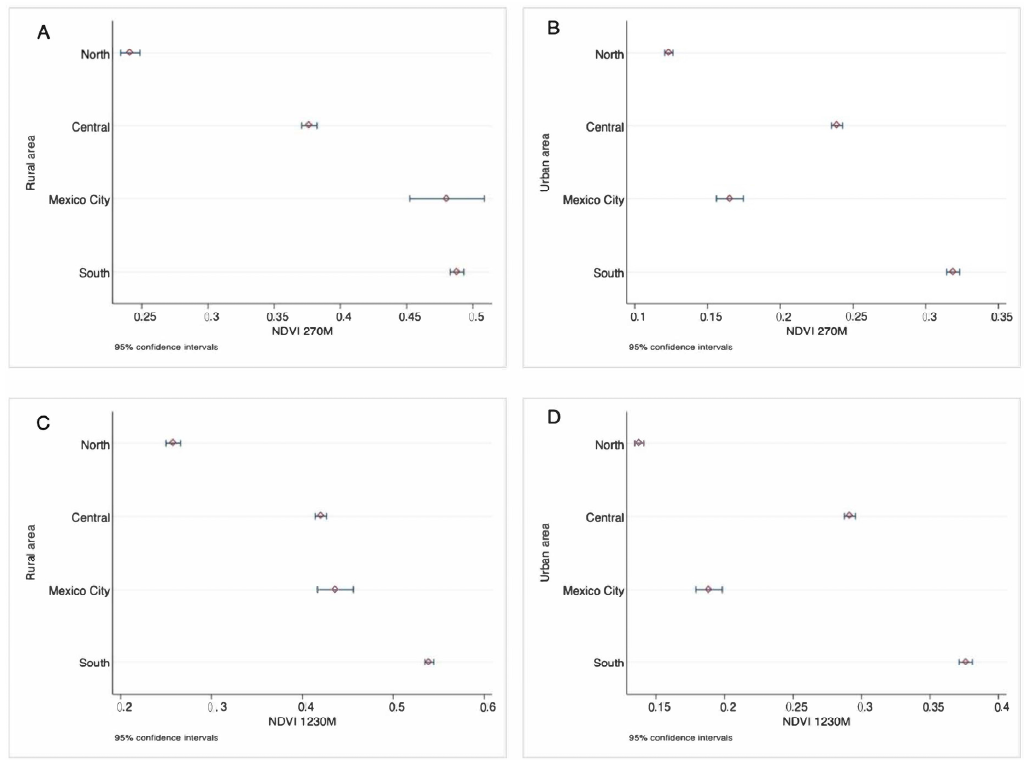
Figure 2. Distribution of NDVI by regions of Mexico during the summer of 2018, ( A ) buffer 270 m rural area, ( B ) buffer 270 m urban area, ( C ) buffer 1230 m rural area, ( D ) buffer 1230 m urban area.